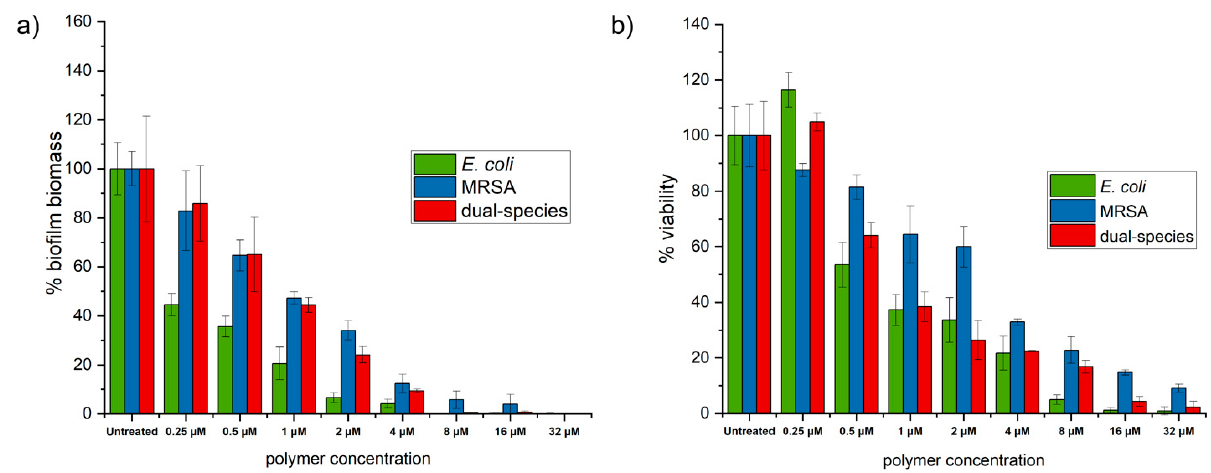
Figure 3. ( a ) Biomass and ( b ) bacteria viability of 2-day-old mono- and dual-species biofilms of MRSA IDRL-6169 + E. coli IDRL-10366 after 3 h treatment with PNPs. The data shown are averages of triplicates with the error bars indicating standard deviations.